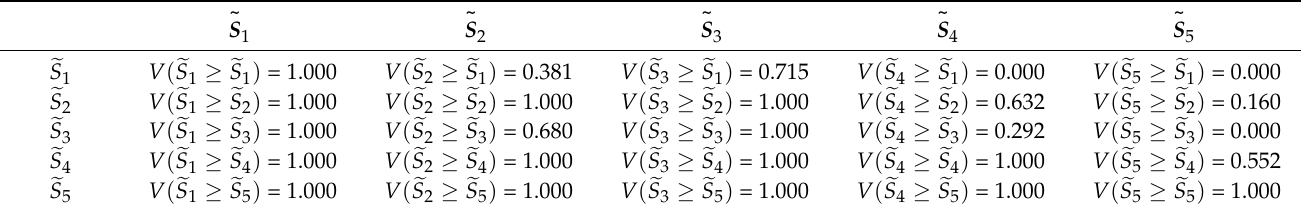
Table 5. Table 5. Values of V ( (cid:101) S i ≥ (cid:101) S j ) .